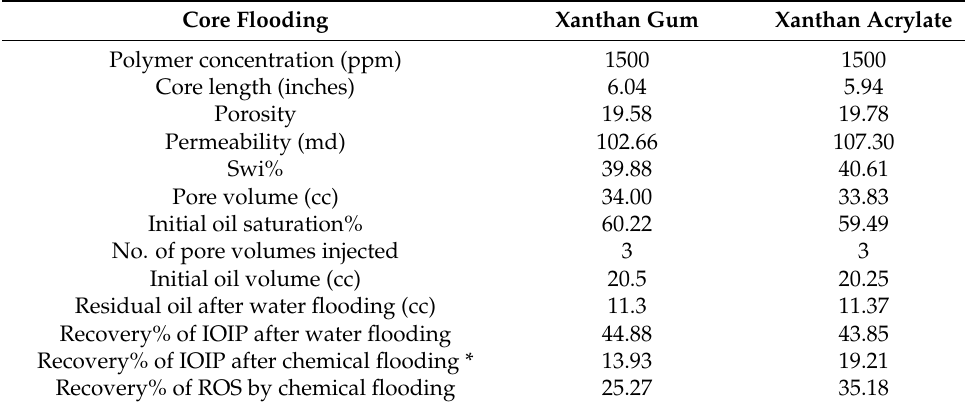
Figure 5. Total oil recovery from the sandstone core after flooding with brine (3% NaCl) and 1500 mg/L ppm xanthan gum acrylate mixture. Table 1. Comparison of core flood